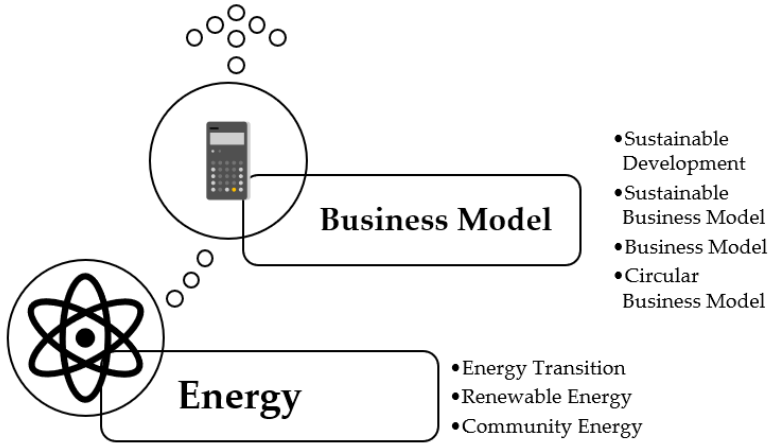
Figure 15. Main topics of Energy–Business Model Clusters.